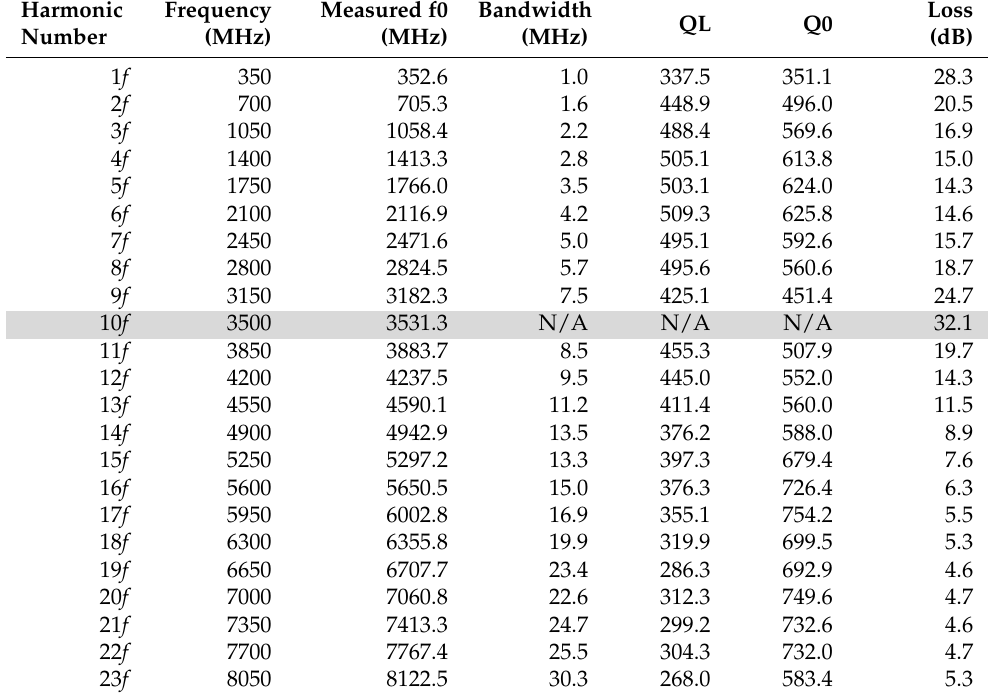
Table 1. Measured (air) results of the harmonic resonance coaxial probe.